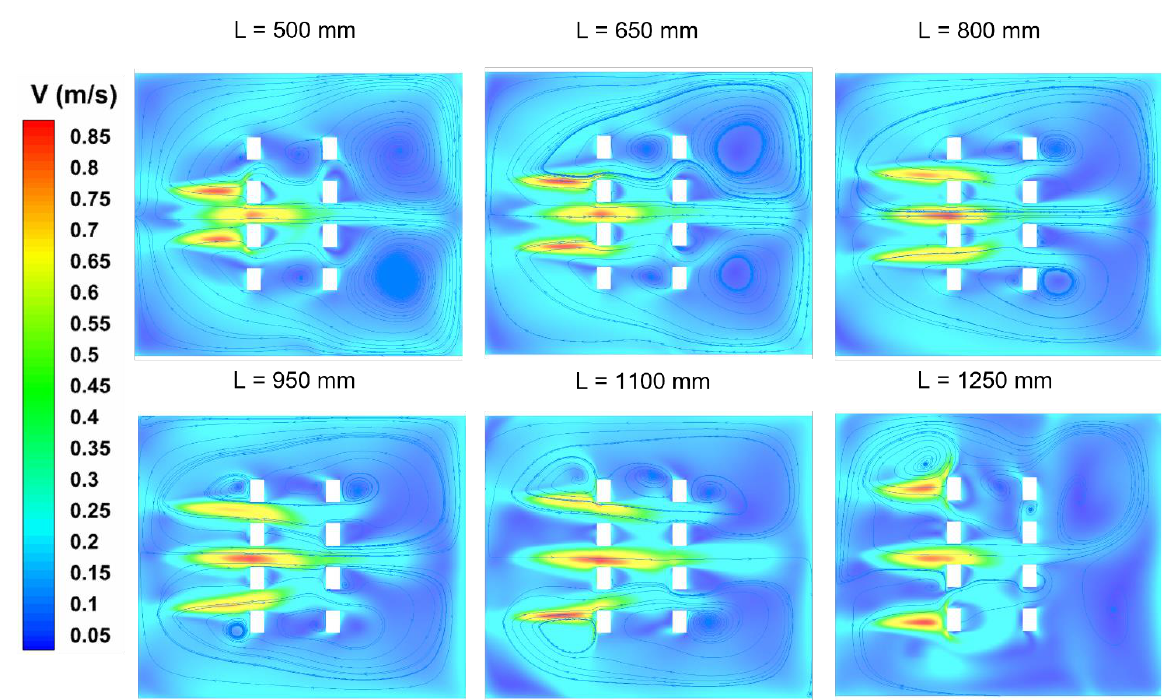
Figure 11. Velocity distribution contour in the plane z =1.1 m with different air inlet spacings.